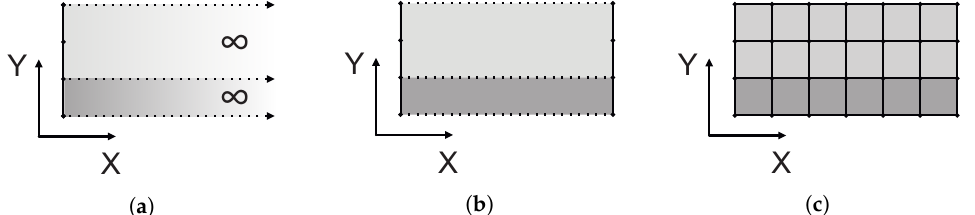
Figure 1. Schematic discretisation of: ( a ) an unbounded (infinite) domain in the scaled boundaty finite element method (SBFEM) ( b ); a domain in the SBFEM; and ( c ) in classical FEM.